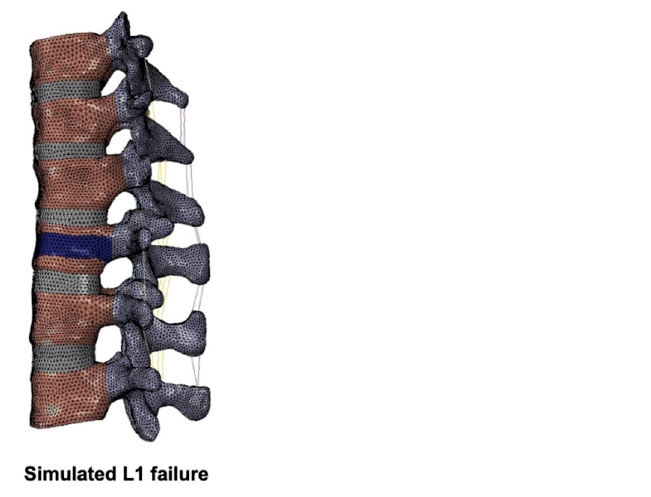
Figure 1. Finite element model of T10-L3 TL spine and simulation of L1 failure. The present finite element model of the intact spine ( left ) and simulated L1 failure ( right ). The weakened materials were indicated in blue. Table 1. Material properties and mesh types of the FE model.